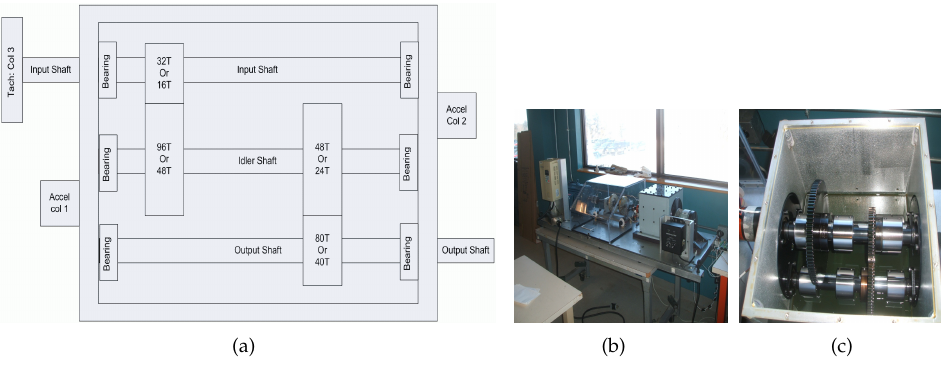
Figure 10. The gearbox used in PHM 2009 Challenge Data: ( a ) gearbox schematic; ( b ) gearbox apparatus; and ( c ) gearbox inside